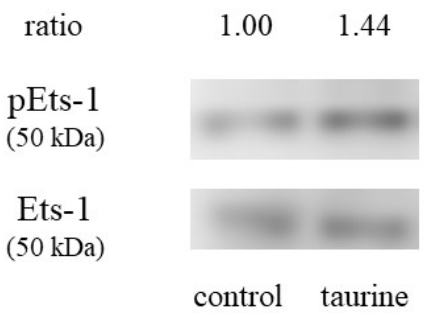
Figure 8. Effect of taurine on the phosphorylation (activation) of Ets-1. Caco-2 cells were cultured in a medium containing 100 mM of taurine for 3 h. The cell lysate was recovered and used for the western blot analysis. The bands were quantified using an image gauge.